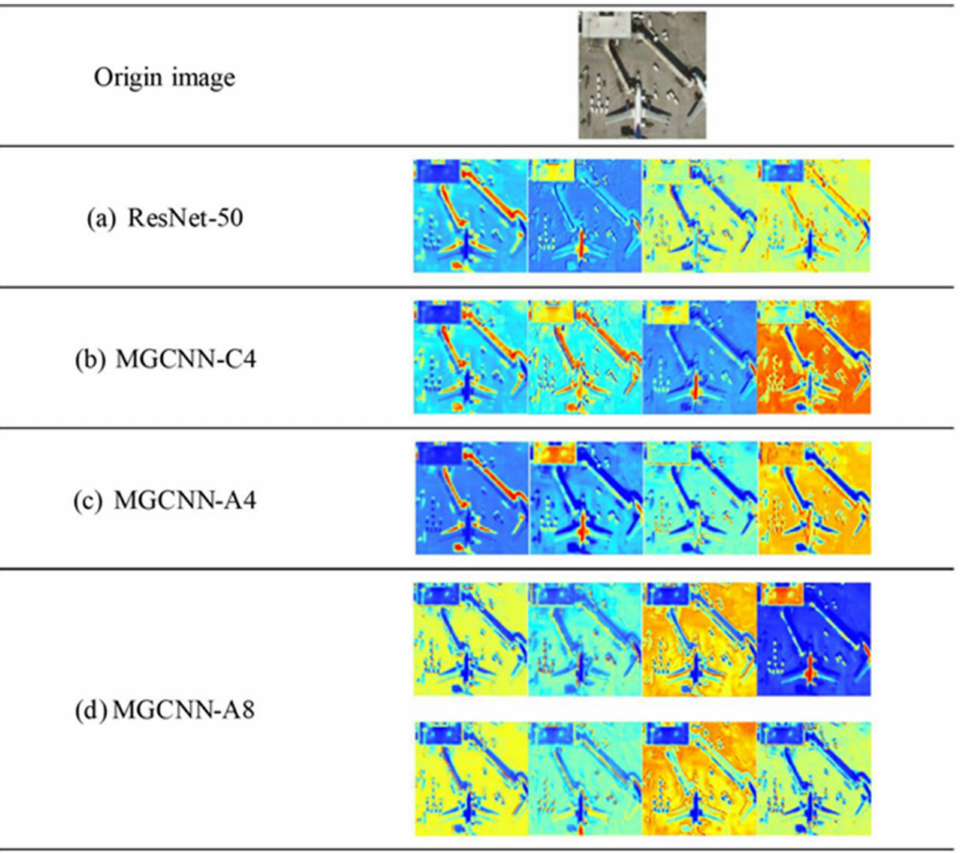
Figure 15. Feature maps extracted with the proposed models for comparisons. Figures ( a – d ) are feature maps of each